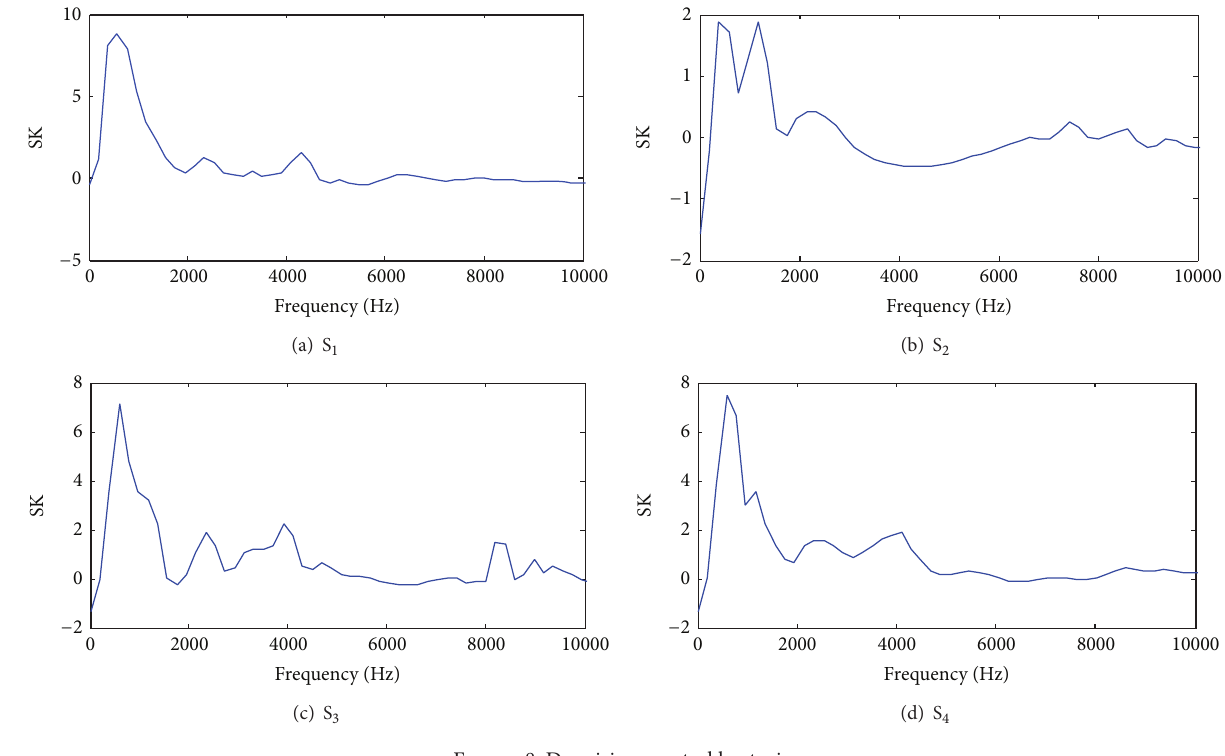
Figure 8: Denoising spectral kurtosis.